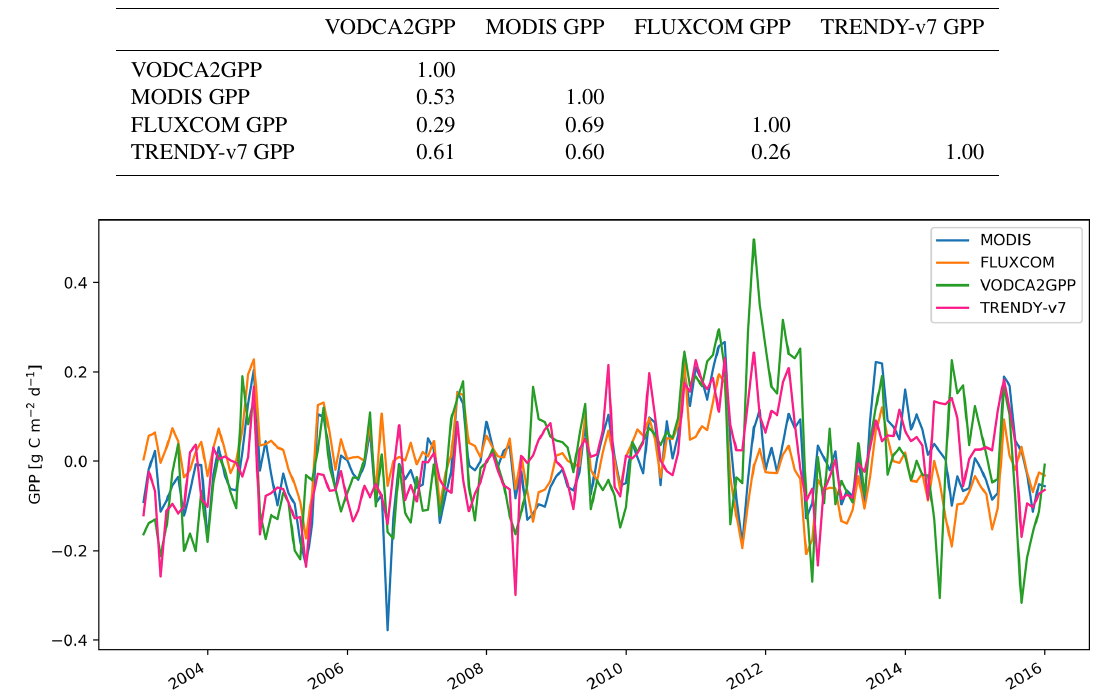
Table 2. Pearson’s r correlation matrix for mean global monthly GPP anomalies between 2002 and 2016.